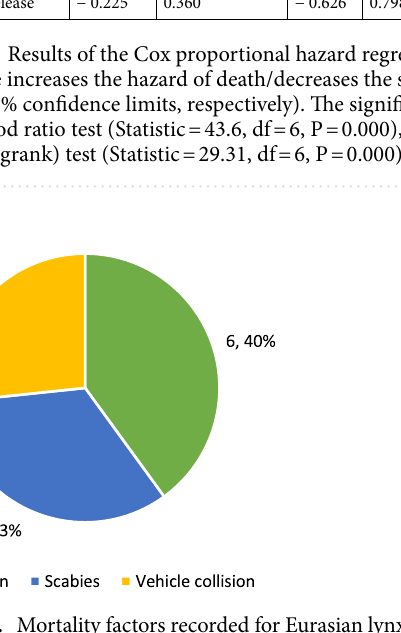
Figure 6. Mortality factors recorded for Eurasian lynx released as part of the reintroduction programme in north-western Poland (2019–2021).